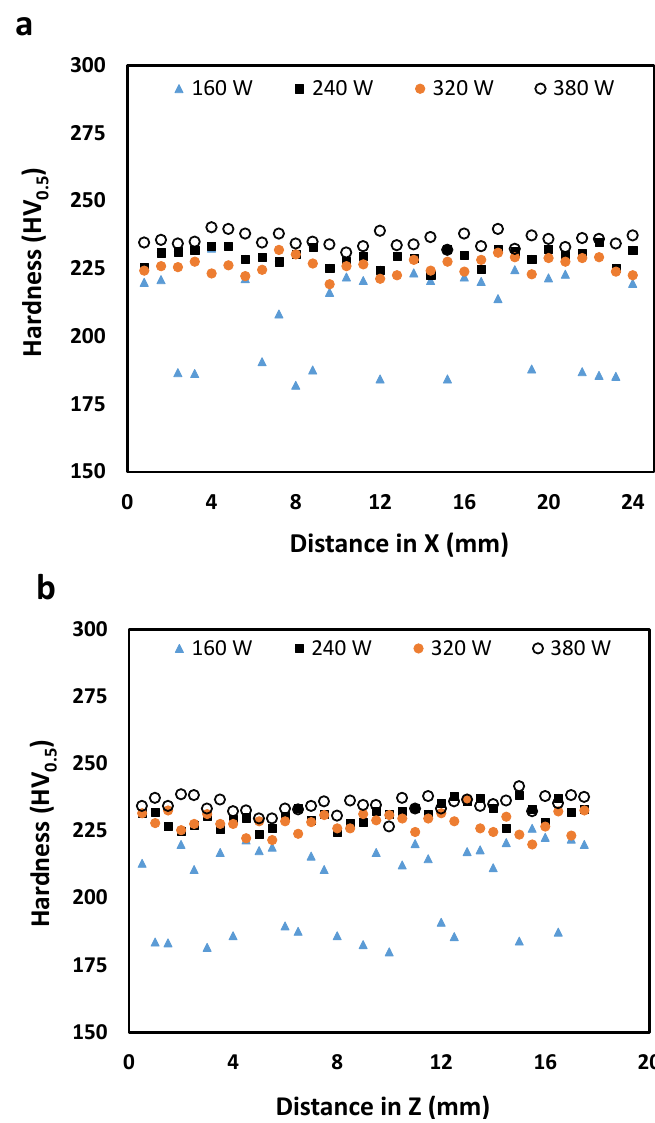
Figure 11. Variation in the microhardness of as-built 316LSS produced at different laser powers: ( a ) TD and ( b ) BD.